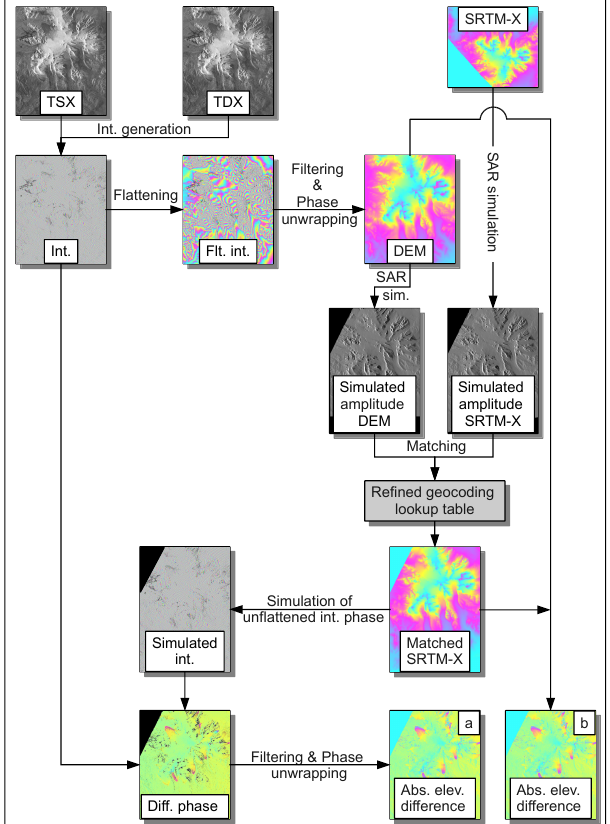
Fig. 2. Scheme of the DInSAR approach and the DEM differencing applied in this study. The abbreviations used in this figure are as follows: TSX, TerraSAR-X SSC; TDX, TanDEM-X SSC; SRTM- X, SRTM-X DEM; Int., interferogram; Flt. int., flattened interfero- gram; DEM, TSX/TDX DEM; SAR sim., SAR simulation; Simu- lated int., simulated interferogram; Diff. phase, differential phase; Abs. elev. difference, absolute surface elevation differences derived by DInSAR (a) , and absolute surface elevation differences derived by DEM differencing (b) .